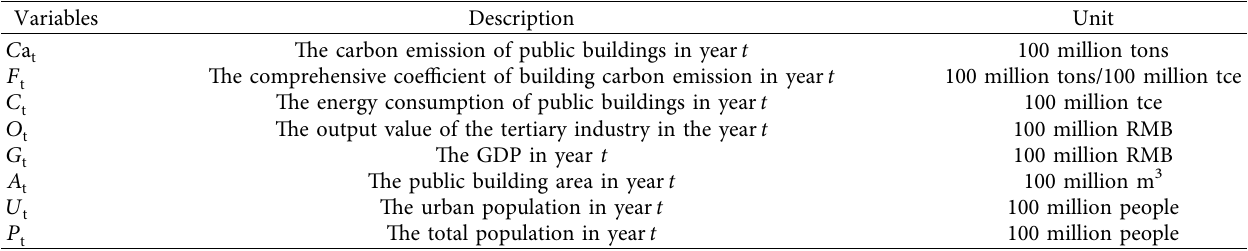
Table 1: Variable description of formula